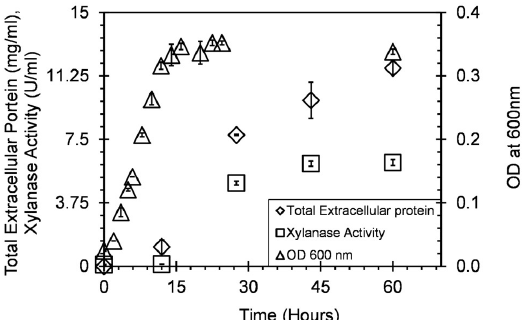
Figure 1. The growth, total extracellular protein, and xylanase activity profile of Geobacillus sp. strain DUSELR13 grown on 0.05% ( w / v ) xylan as the substrate at 60 °C. The values are the means of three set of experiments and the error bars represent ± SD of the means with n = 3.